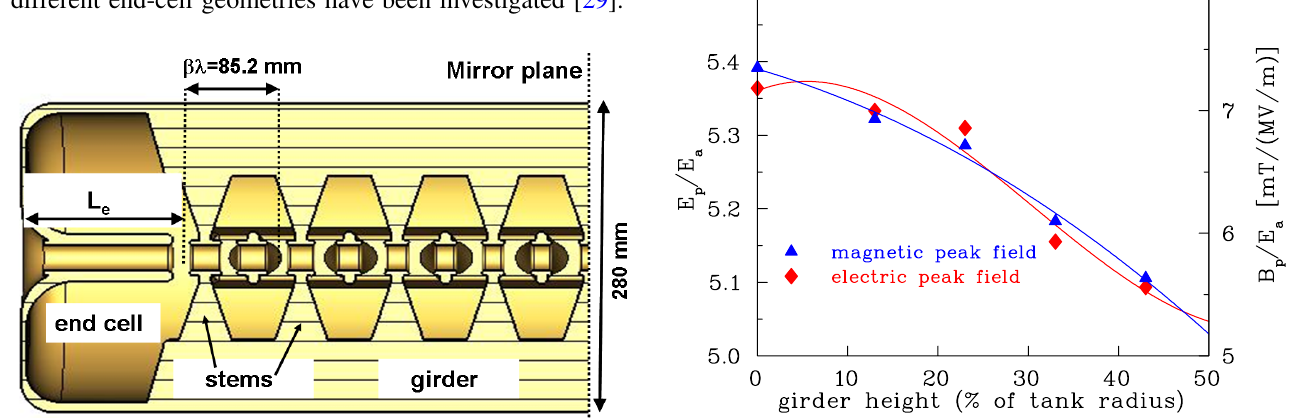
FIG. 4. (Color) 2D cut of the realized sc CH-cavity geometry.